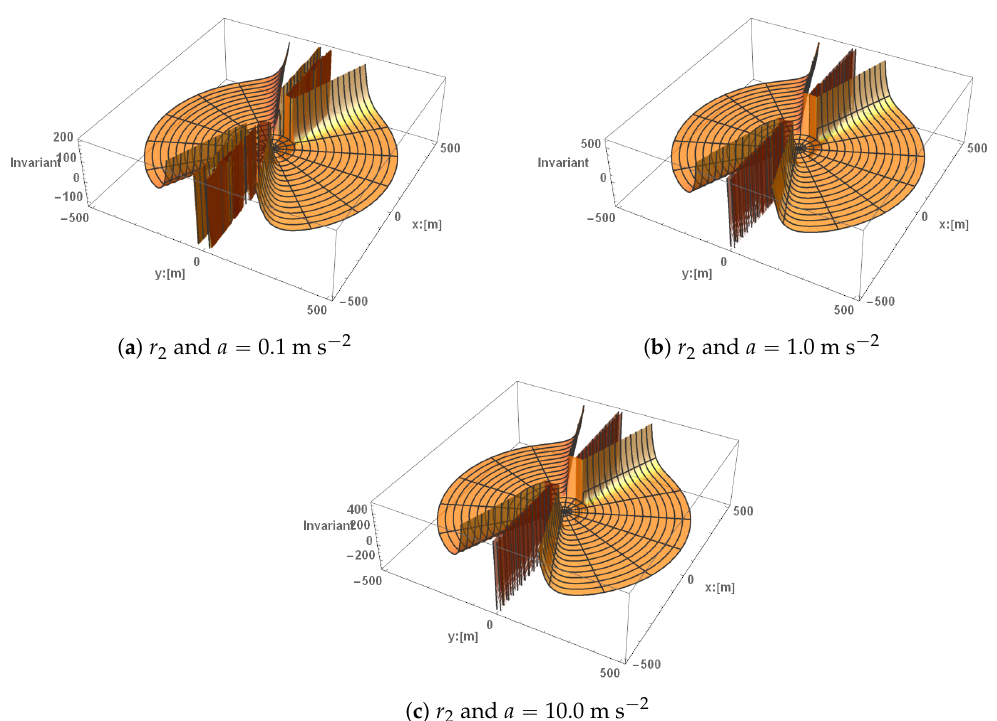
Figure A5. The acceleration, a , of the invariant r 2 is plotted in the figures above. The other parameters were set to be σ “ 50,000 m ´ 1 , ρ “ 100 m, and t “ 1 s. The plots were rendered using Mathematica’s ® RevolutionPlot3D. It plots a function by rotating the function around the z-axis. The amount that the space diverges from being flat is represented by the invariant function’s magnitude, and its amount is labeled on the vertical axis. The x and y-axis are displayed on the plots, and they display the distance from a spaceship in the flat portion at the center of each figure. Each radial line in the plot corresponds to a distance of approximately 33 m. The constant portion to the right of the harbor is to the front of the warp bubble, and the constant portion to the left of the harbor is the back of the warp bubble.